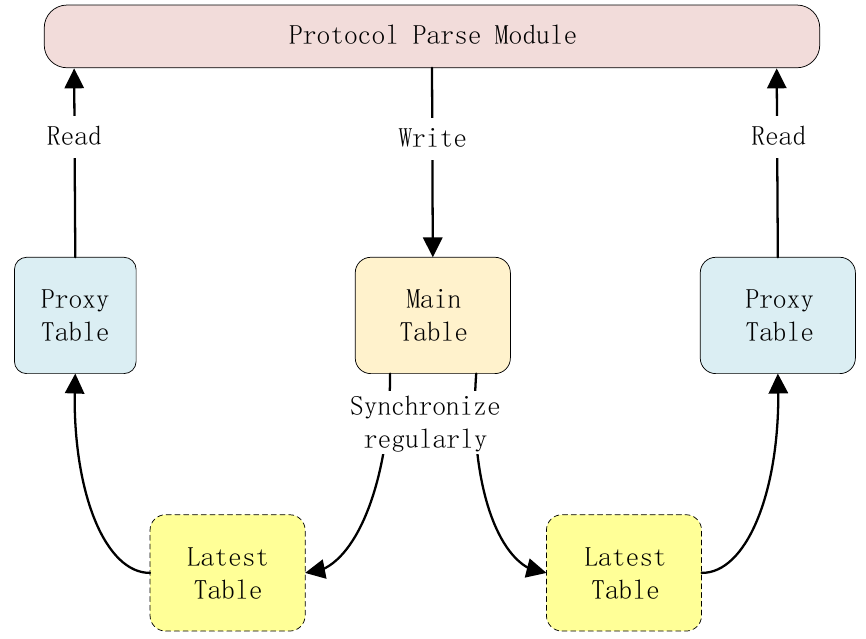
Figure 6. One-main and multi-proxy synchronization